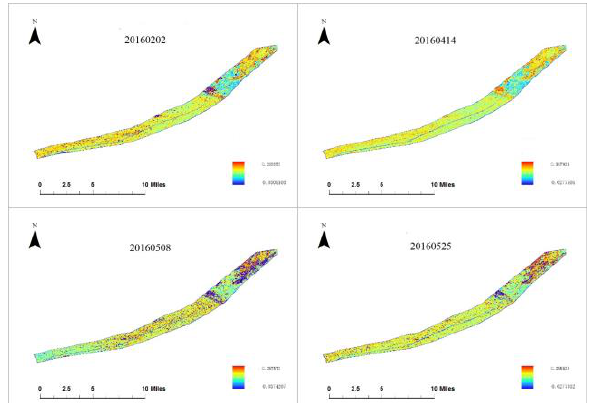
Figure 2. Soil moisture distributions derived from Sentinel-1A over the study area